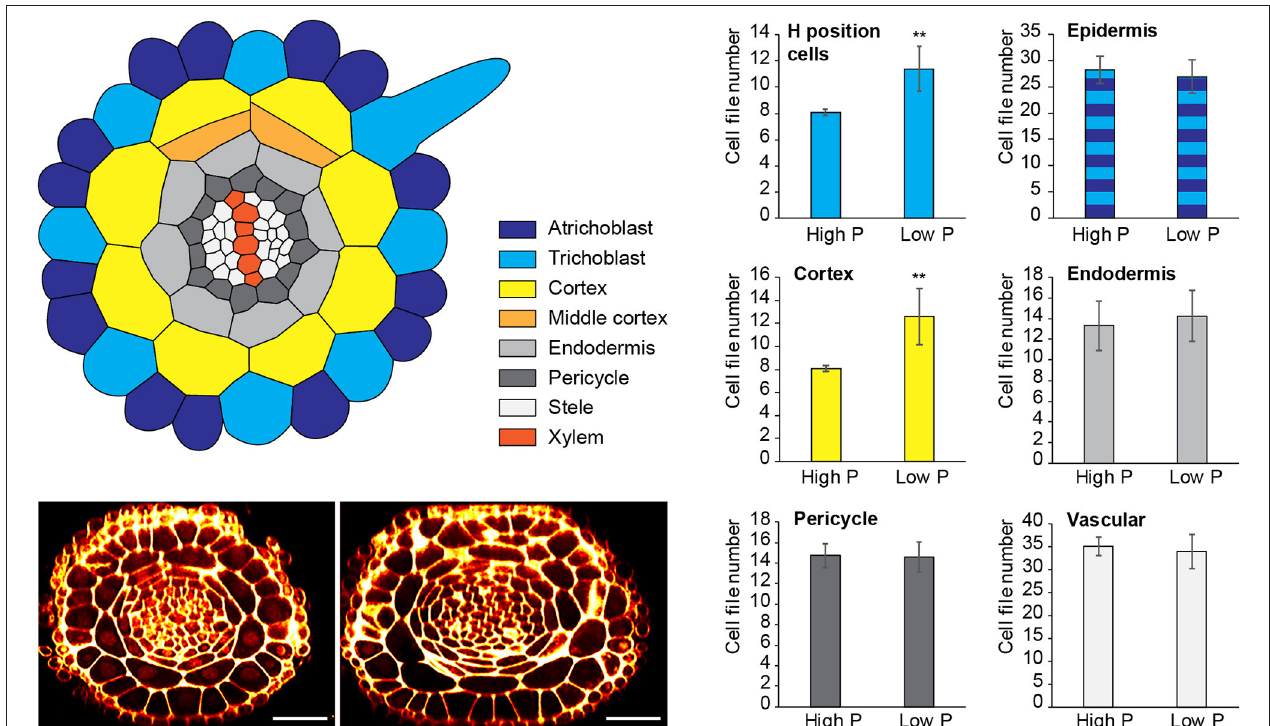
FIGURE 1 | Changes to radial anatomy under low phosphate are limited to changes in cortex and hair-cell number. Schematic diagram showing the radial organization of tissues in the Arabidopsis root. Concentric rings of tissues can be seen radiating out from the central vascular cylinder; trichoblast positions in epidermal cells at the cleft between two cortex cells can be seen (light blue). Layers of middle cortex can be seen beginning to form at the xylem poles (orange). Representative images of high Pi (Left) and low Pi (Right) treated roots in transverse section show how the radial organization differs between treatments, scale bar = 50 µ m, Bar charts showing number of cells files in each tissue visualized in confocal microscope cross sections for two phosphate treatments: “high P” (1mM), “low Pi” (50 µ M). Roots of seedlings growing on high Pi (1mM), or low Pi (50 µ M) have, on average, 8 and 12 cortex cell files respectively ( p ≤ 0.001). This change corresponds to a change in the average number of hair position epidermal cell files (H cells) of 8 to 11 (** p ≤